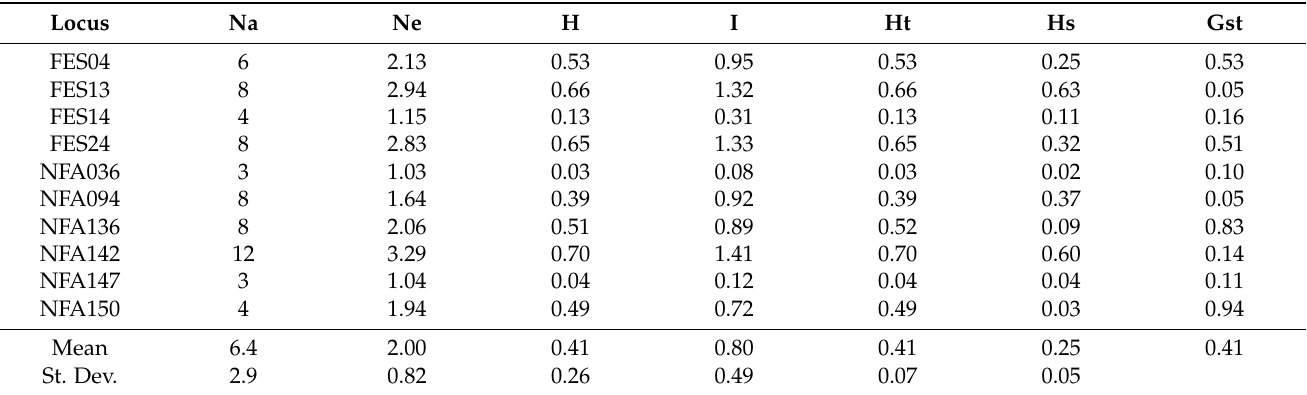
Table 2. Estimates of different genetic diversity parameters for the 10 polymorphic EST-SSR loci across the 43 Bolivian fescue populations.